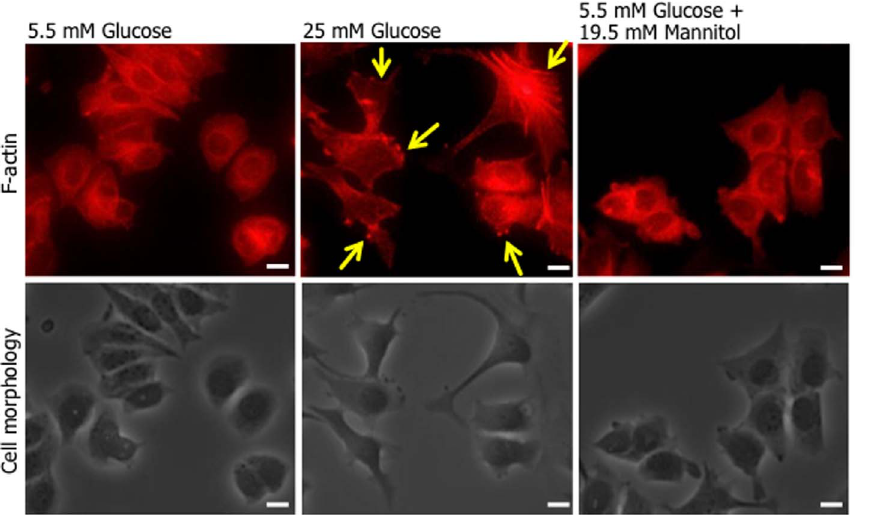
Figure 2. The formation of lamellipodia and morphology in MCF-7 cells cultured with high glucose level. MCF-7 cells plated on Collargen IV-coated coverslips were cultured with normal (5.5 mM), high (25 mM) D-glucose concentration, or an osmotic control (5.5 mM D-glucose plus 19.5 mM D-mannitol) medium for 24 h. Cells were fixed with 3.7% formaldehyde, permeabilised with 0.1% Triton X-100 and stained with Alexa Fluor H 546-labelled phalloidin. Upper panels; fluorescence images, lower panels; phase-contrast images. Representative results of 3 independent experiments are shown. Arrows show representative lamellypodia formations. Bars: 10 m m.